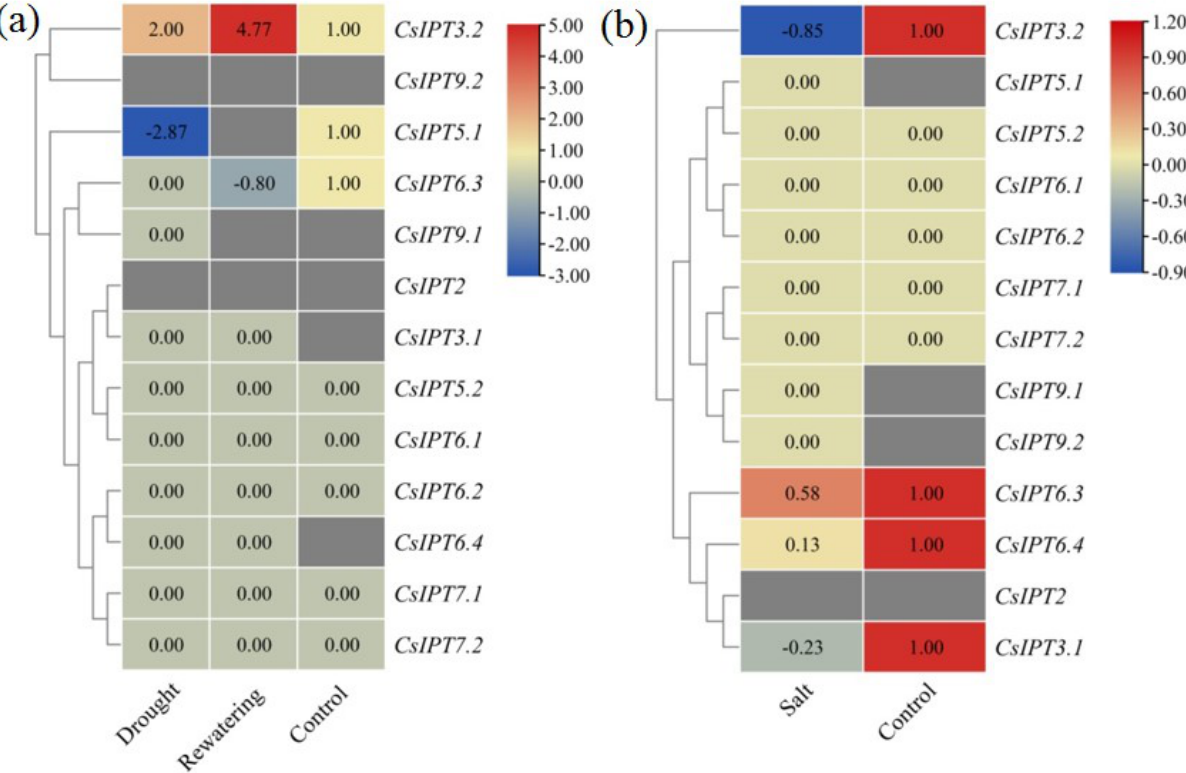
Figure 9. Expression profiles of CsIPT genes in tea plants in response to drought, rewatering, and salt stresses. Transcriptional levels of CsIPT genes under drought-stress and recovery ( a ). Transcriptional levels of CsIPT genes under salt-stress ( b ).